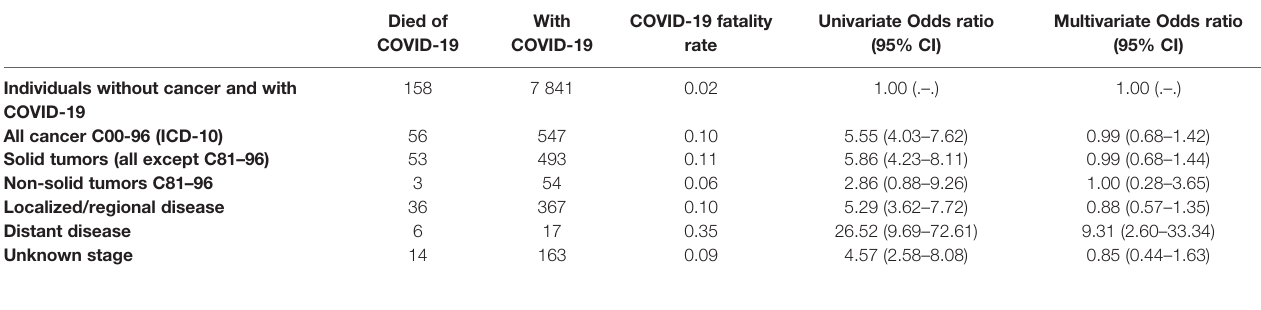
TABLE 5 | Rates of death due to COVID-19 and/or admission to hospital due to COVID-19. Cancer patients died or admitted to hospital because of COVID-19